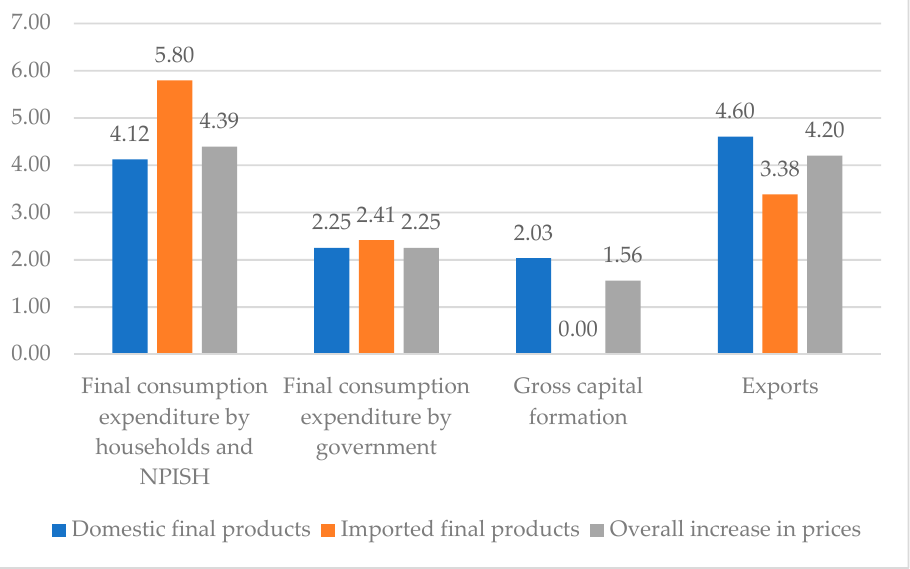
Figure 4. Comparison of domestic and import prices for certain categories of final demand due to the increase in energy prices on the world market of 63%, in %.